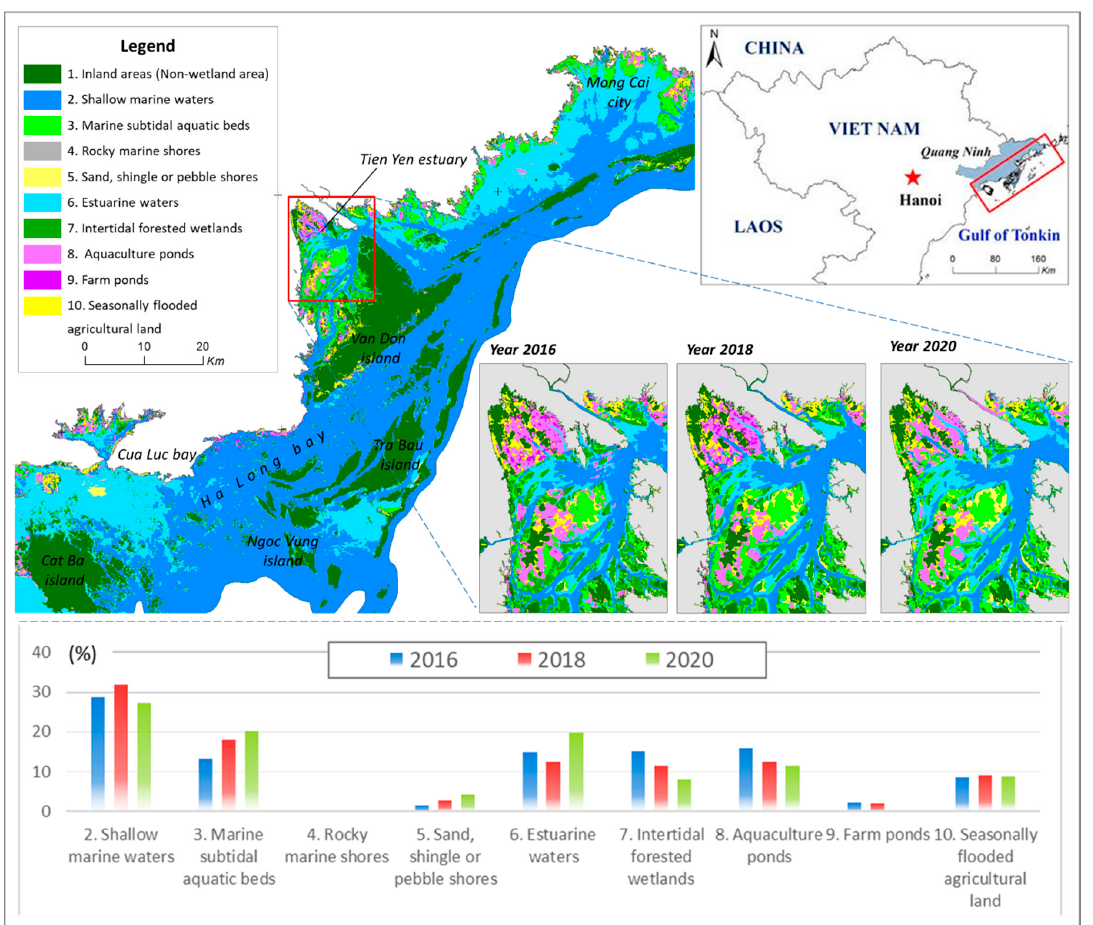
Figure 8. Distribution of wetland types in the northeastern part of Vietnam and their areal percentage changes in Tien Yen estuary in 2016, 2018 and 2020 based on the use of the Adam-ResU-Net model. Additionally, Figure 8 also shows the areal percentage changes of wetland types in the Tien Yen estuary area in 2016, 2018, and 2020. The area of the “shallow marine waters” and the “estuary waters” are inversely proportional change. The area of shallow waters was narrowed from 29% of the area in 2016 to 27% in 2020, while the estuarine area was expanded from 15% in 2016 to 20% in 2020. It shows that the natural activity of the river to transport alluvium materials to the sea is getting stronger after the recent four years. Sand and mud were accumulated to form small islands, sandbanks, and tidal flats. The area of farm ponds and aquaculture ponds has been narrowed, from 16% in 2016 to 11% in 2020. According to the interviews in 2020, the aquaculture production is reduced significantly due to urbanization in the wetland area of the Quang Ninh province. It led to the land-use conversion from wetland to new urban. In 4 years, local economic development and uncontrolled population rate are increasing in the research area have led to a sharp decrease of mangrove area up to 50% of the area. Therefore, the program to a ff orest and protect mangrove ecosystems has been interested in some coastal communes of Tien Yen River by the district committee. It is reflected through the